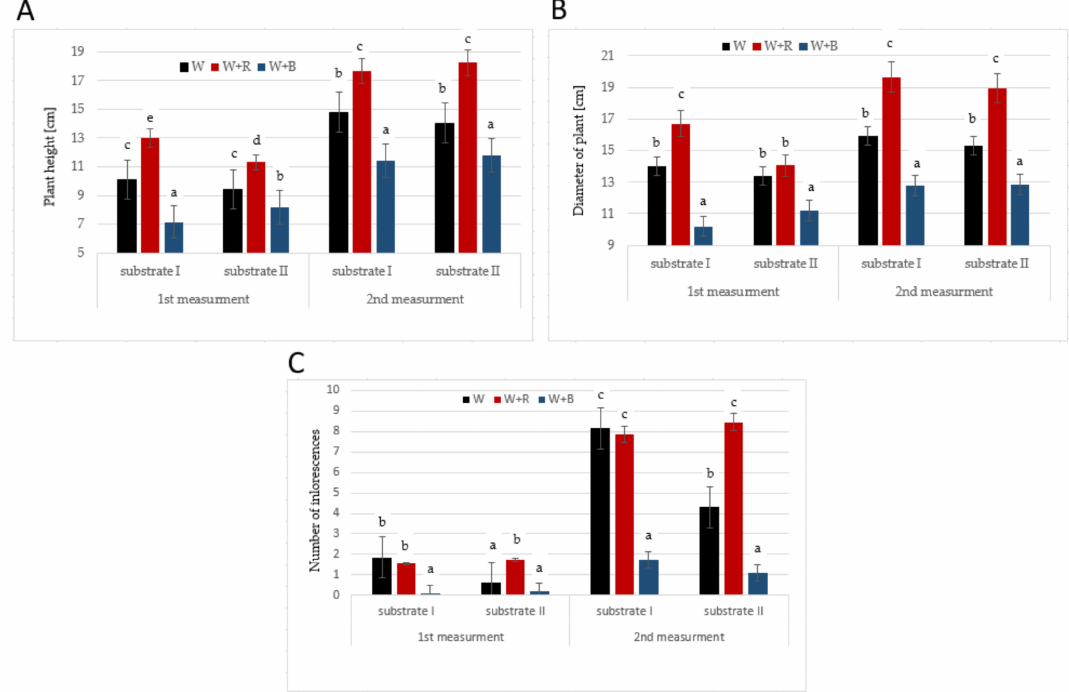
Figure 2. Plant height ( A ), diameter of plants ( B ) and number of inflorescences ( C ) of Tagetes ‘Petite Gold’ and ‘Petite Orange’ depending on the substrate and light used. Means followed by the same letters are not significantly